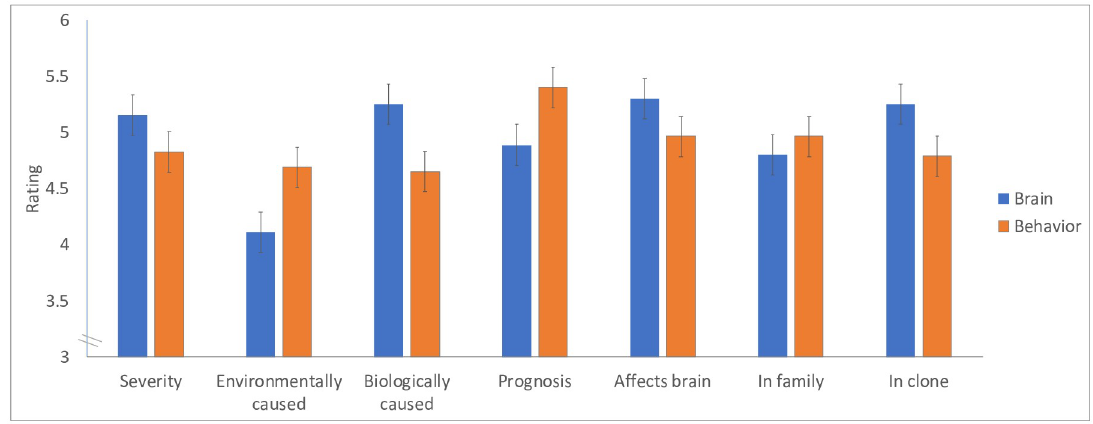
Fig 4. The evaluation of reading disorders diagnosed by a behavioral and brain